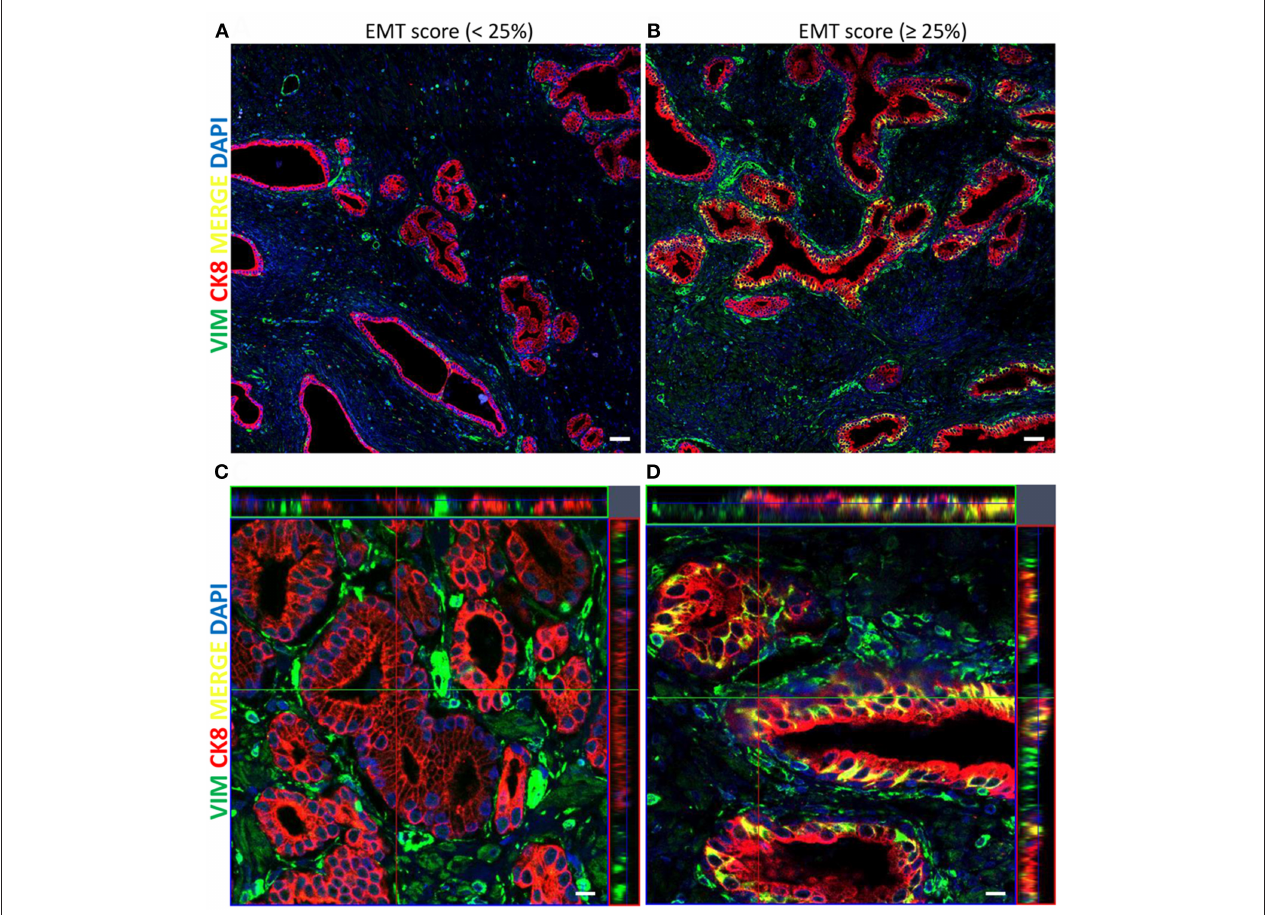
FIGURE 2 | Representative immunofluorescent images of the co-expression of CK8/Vim molecular markers in PCa tissue specimens stained with CK8 (red), Vimentin (green), and DAPI (blue). (A) Tile scan image (5 x 5) of PCa tissue showing low EMT score < 25% (scale bar = 50 µ m). (B) Tile scan image (5 x 5) of PCa tissue showing high EMT score ≥ 25% (scale bar = 50 µ m). (C) Z-stack with maximal and orthogonal projection of PCa tissue showing low EMT score < 25% (scale bar = 10 µ m). (D) Z-stack with maximal and orthogonal projection of PCa tissue showing high EMT score ≥ 25% (scale bar = 10 µ m).